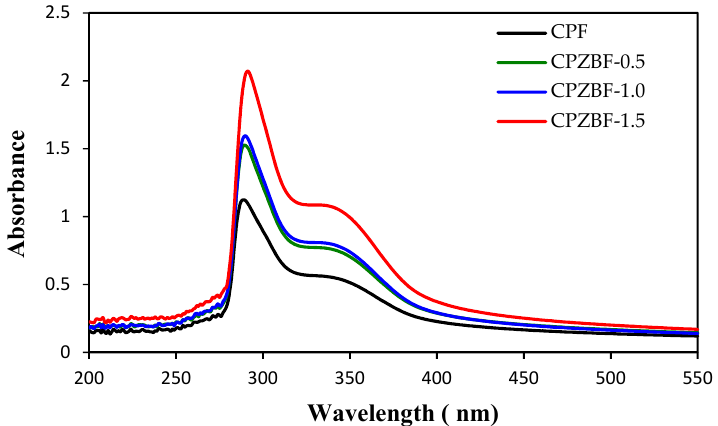
Figure 3. UV–visible spectra of crosslinked pectin film (CPF) and crosslinked pectin/ZnO bionano- composite films (CPZBF) with 0.5, 1, and 1.5% ZnO nanoparticles.